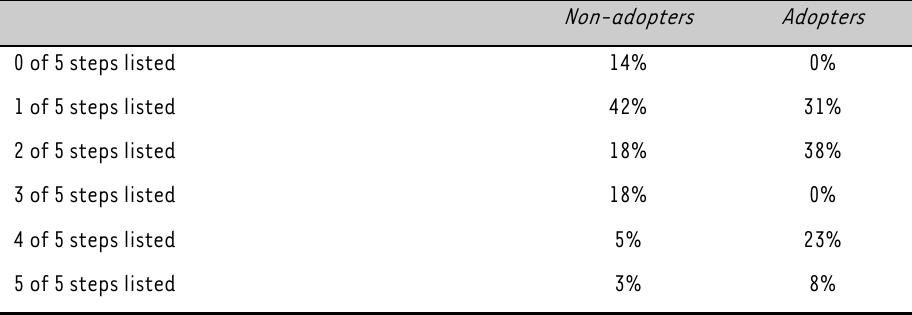
TABLE 4: Steps of strategy implementation process*